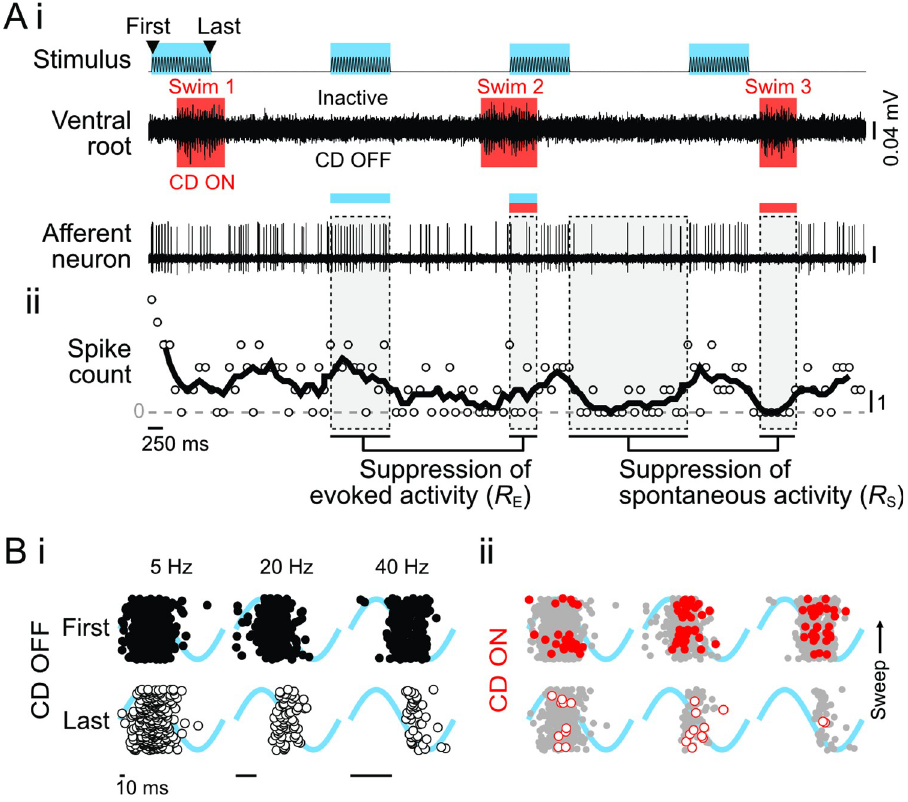
Fig 3. Dynamics of afferent neuron spike activity in response to neuromast deflection depend on CD. (A) (i) Experiments were performed during open-loop stimulation (first to last interval), during which fish swam spontaneously (motor activity recorded through ventral motor root). The CD was ON during swim bouts and OFF while the fish was inactive. Afferent neuron spiking depended on the combination of stimulation and motor activity, as shown by the moving average of spike count (ii). Individual spikes were classified as evoked (E) when the stimulus was present or spontaneous (S) otherwise. The effect of CD on evoked and spontaneous activity was quantified by the ratio of CD ON/CD OFF, respectively, R E and R S . (B) Raster plot of evoked afferent spike phases during the first and last periods of 5, 20, and 40 Hz stimulation. Stimulus phase is underlaid in blue. (i) In this afferent neuron, when CD OFF the afferent neuron exhibited a strong response to the first stimulus, but a delayed and weaker response to the final stimulus. (ii) In CD ON, there was a reduction of both the number of spikes and the response interval with respect to CD OFF (replicated in gray). In each plot, sweeps progress from bottom to top. All data from one representative individual. Gaps between sweeps arise when the fish ceases swimming due to open-loop stimulation [70]. The data and code underlying this figure may be found at DOI: 10.6084/m9.figshare.13034012. CD, corollary